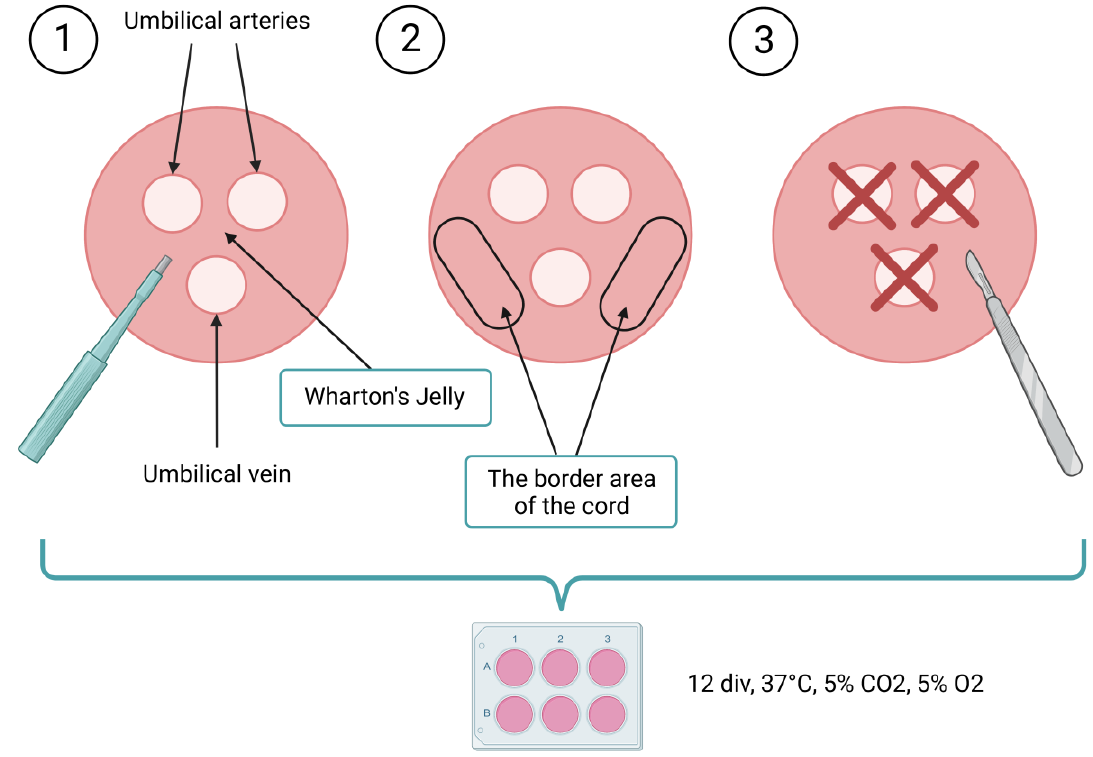
Figure 8. Experimental design.